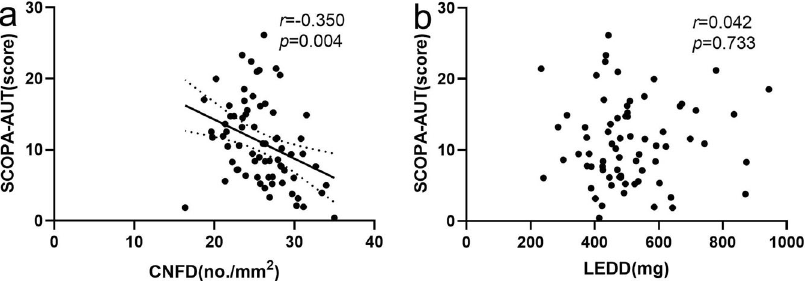
Fig. 4 Association between SCOPA-AUT with CNFD and LEDD. a , b Partial correlation plots and standardized correlation cof fi cients between autonomic symptoms and CNFD. SCOPA-AUT the scale for outcomes Parkinson ’ s disease for autonomic symptoms, CNFD corneal nerve fi ber